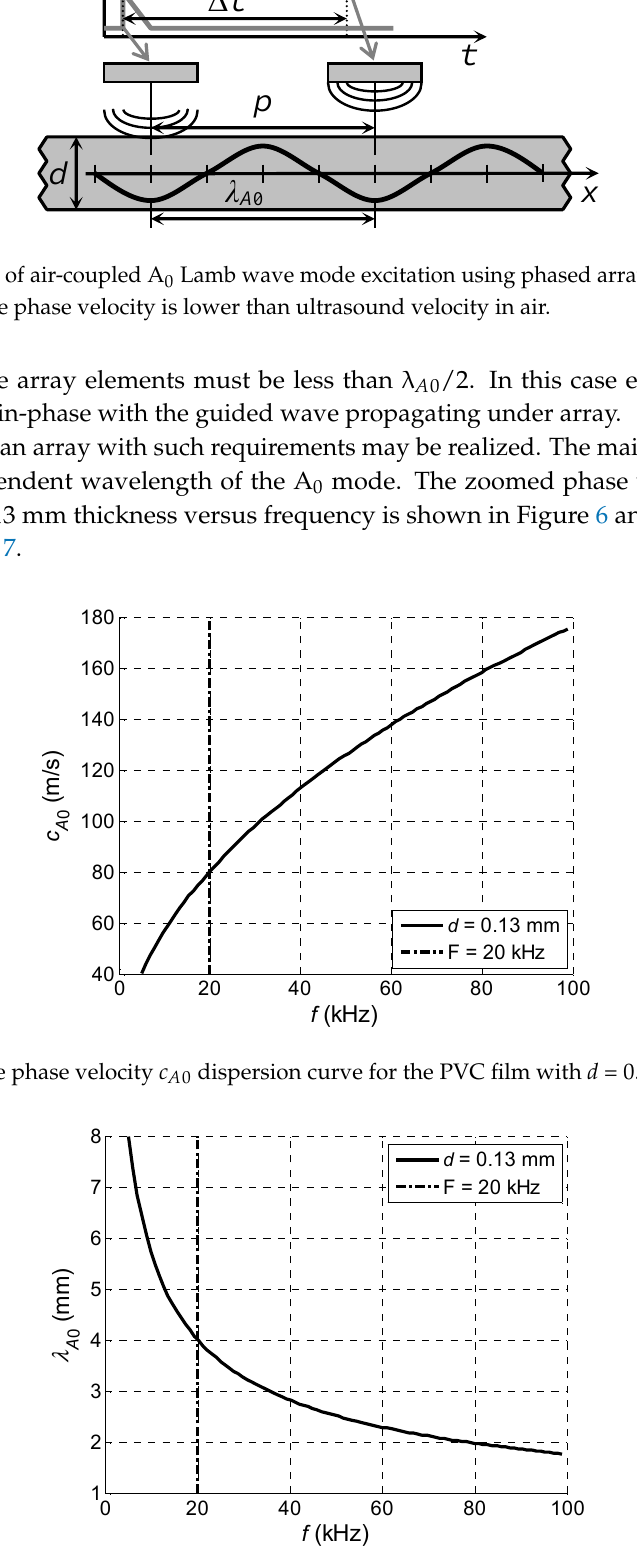
Figure 7. A 0 mode wavelength λ A 0 versus frequency f for PVC film with d = 0.13 mm thickness.